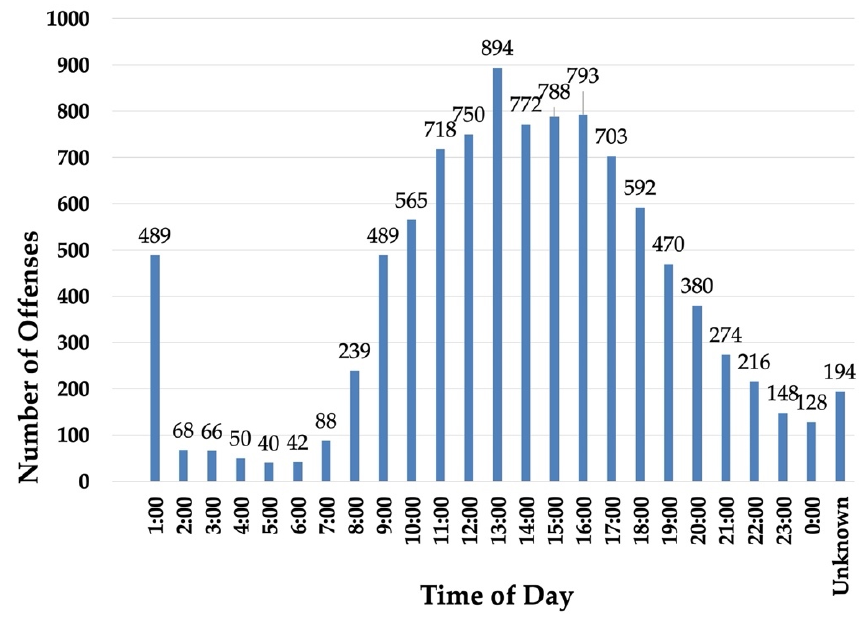
Figure 4. Animal Cruelty vs. Time of Day.